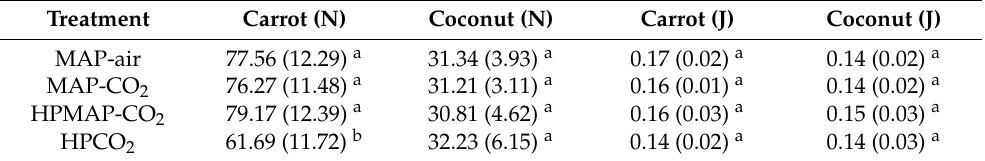
Table 1. Texture analysis: effect of the different treatments on the cutting test (N) and textural firmness (J), carried out on carrots and coconut. Treatment conditions were the same as detailed in Section 3.1. Values in brackets are SD. Means with different small superscript letters in the same column are significantly different ( p <